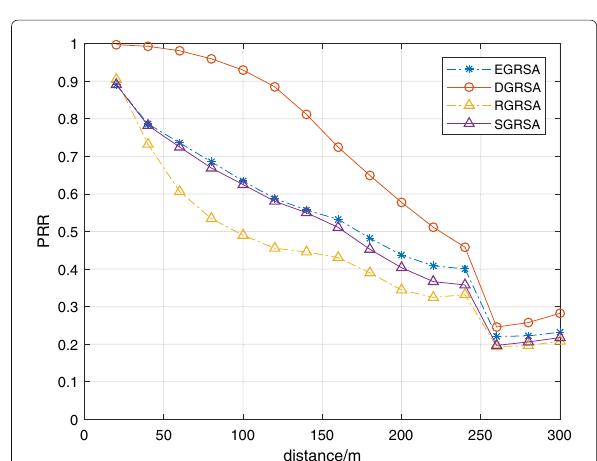
Fig. 17 The PRR of DGRSA when the number of VUEs is 900 in the jam scene. Figure 17 showsthepacketreception ratio (PRR) curve changing with distance when jam areas are areas 1, 2, 7, and 8 and the number of vehicle user equipments (VUEs) is 900. Four geo-based algorithms, namely random geo-based resource selection algorithm (RGRSA), sensing geo-basedresourceselection algorithm (SGRSA), the proposed enhanced geo-based resource selection algorithm (EGRSA), and the proposed dynamic geo-based resource selection algorithm (DGRSA), are compared in this figure. The line with red circles represents the proposed DGRSA. The line with blue stars represents the proposed EGRSA. The line with purple triangles represents the SGRSA. The line with yellow triangles represents RGRSA